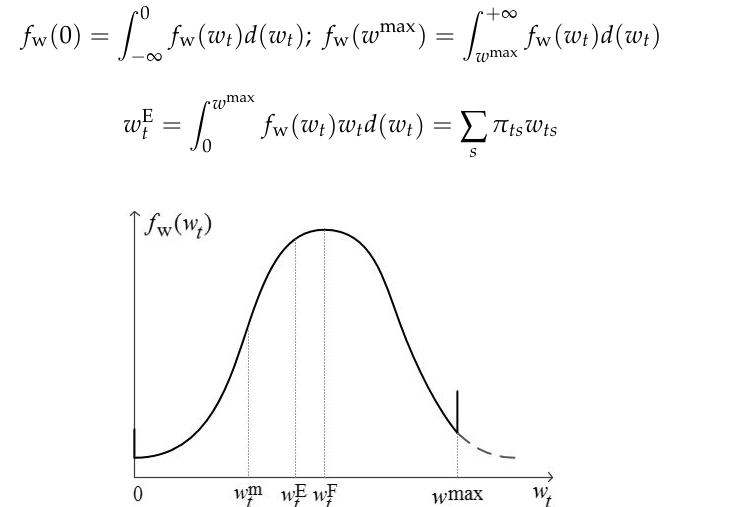
Figure 3. The PDF of wind power production.